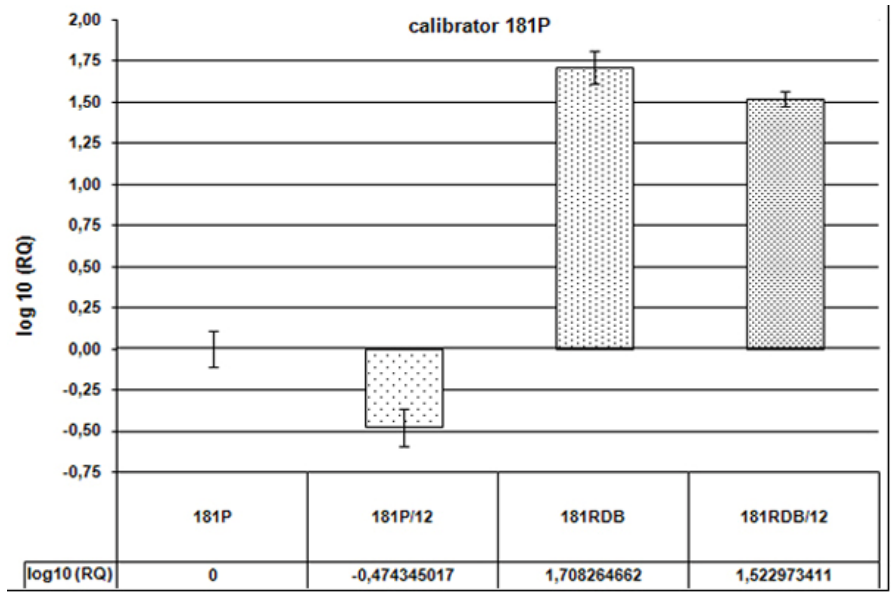
Figure 6. Expression of ABCB1 gene—Relative analysis (RQ) as compared to the sensitive cell line (denoted as 181P). Values of RQ: for 181P = 1, for 181P/12 = 0.3355, for 181RDB = 51.08, for 181RDB/12 = 33.34. Calibrator: P